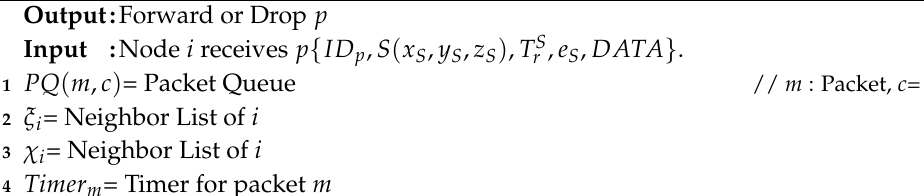
Algorithm 1: Proposed data Packet Forwarding